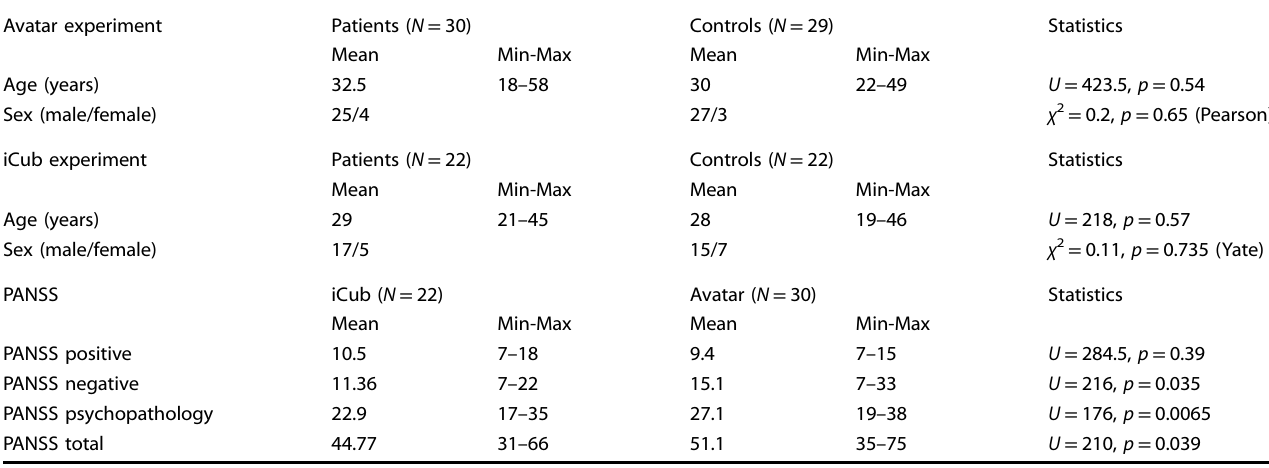
Table 2. Social, demographic and clinical information of schizophrenia patients and healthy controls in the avatar and iCub experiments Avatar